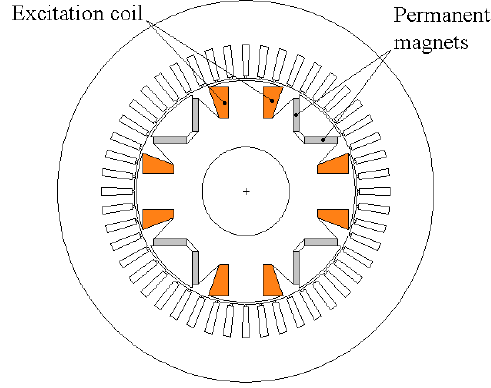
Figure 7. Series hybrid excited structure [6].